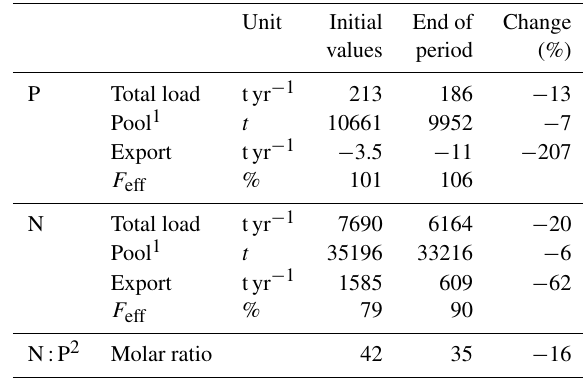
Table 4. The total land load (rivers, land runoff and atmosphere) of P and N (tyr − 1 ) to the Stockholm Archipelago, the size of the ben- thic and pelagic N and P pools ( t ), the export from the area (tyr − 1 ) and the filter efficiency ( F eff ) before and after the nutrient reduc- tions, as well as their percentage changes. The system is in steady state in both cases; thus, the benthic and pelagic pools are in balance with the nutrient